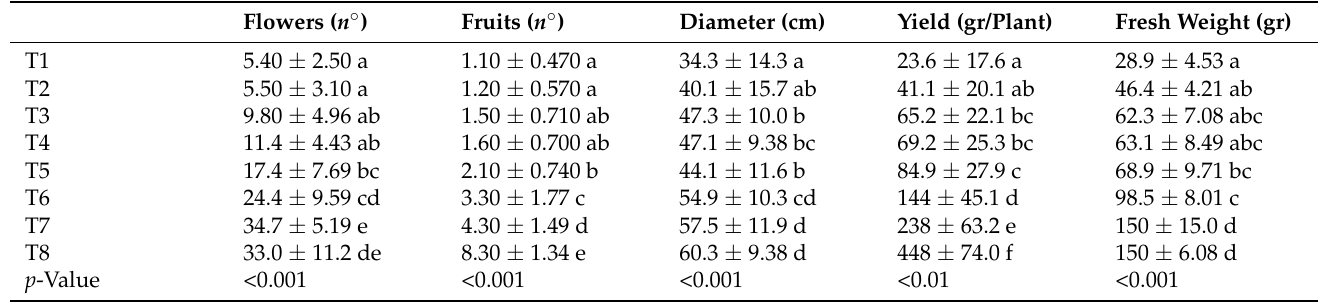
Table 4. Average flower and fruit number, fruit size, yield per plant and fruit fresh weight of tomato plants in greenhouse pot trial under UWP treatments (T1–T7) and Hoagland’s control (T8).